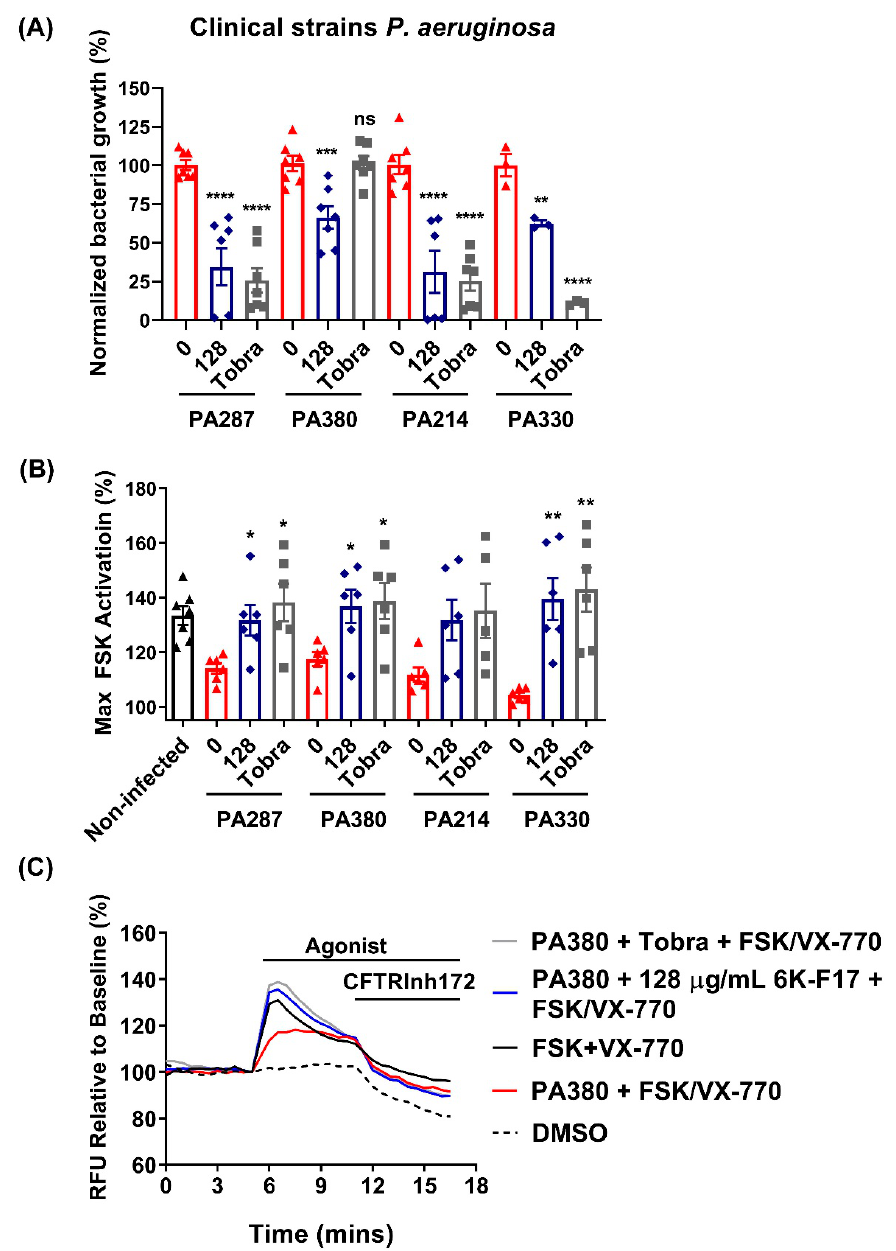
Figure 6. Anti-infectives restore VX-809 rescue of F508del-CFTR channel activity in human bronchial epithelial cells infected with clinical P. aeruginosa strains. F508del-CFTR HBE cells were cultured for 24 h with 3 µ M VX-809 and co-cultured with clinical P. aeruginosa strains isolated from the sputum of CF patients for 4 h +/ − 6K-F17 peptide (128 µ g / mL) or tobramycin (10 µ g / mL). ( A ) Live bacteria were quantified and normalized to bacterial growth on HBE cells alone (0 bar). 6K-F17 significantly inhibits the growth of clinical P. aeruginosa strains, in one instance decreasing growth to a tobramycin-resistant strain (PA380) ( n = 3–6). ( B ) Bar graphs show the mean ( ± SEM) of maximal activation of CFTR after stimulation by FSK and VX-770 ( n = 6; each dot represents one biological replicate). ( C ) F508del-CFTR HBE cells were incubated with 3 µ M VX-809 for 24 h and co-cultured with clinical P. aeruginosa strains +/ − 6K-F17 or 10 µ g / mL tobramycin antibiotic for four hours. Representative traces of F508del-CFTR-dependent chloride e ffl ux in HBE. * p < 0.05, ** p < 0.01; *** p < 0.001; **** p <